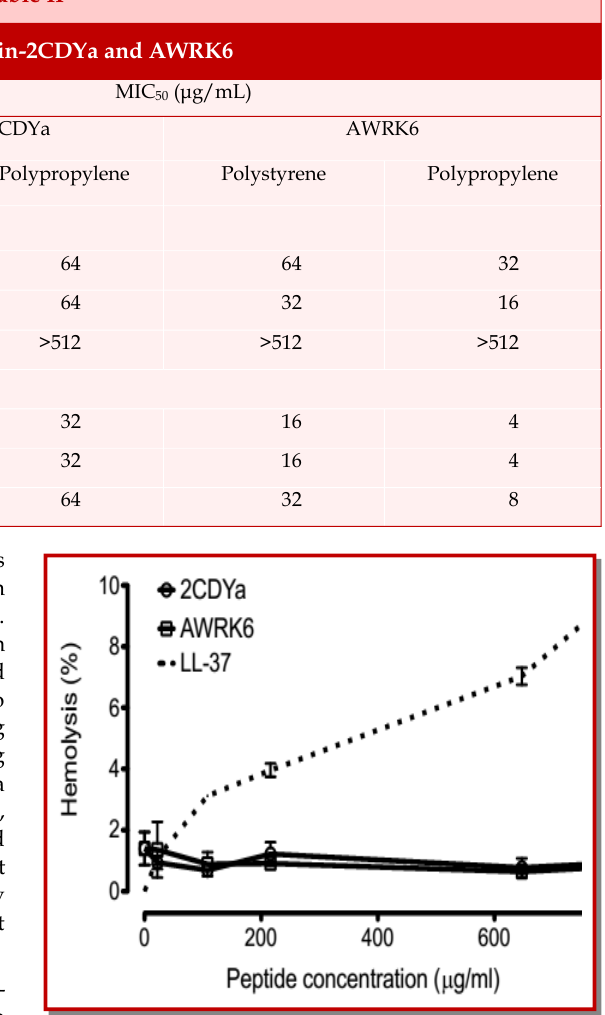
Figure 1: Hemolytic activity of Dy2 and AWRK6 against hu- man red blood cells Fresh hRBC suspension was incubated with each peptide. LL-37 was used as control. The data are the means ± SDs from three replicates or three